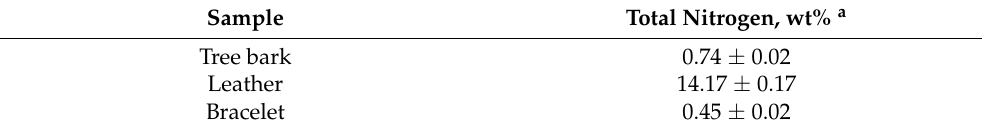
Table 1. Instrumental photon activation analysis (IPAA) results of total nitrogen (according to